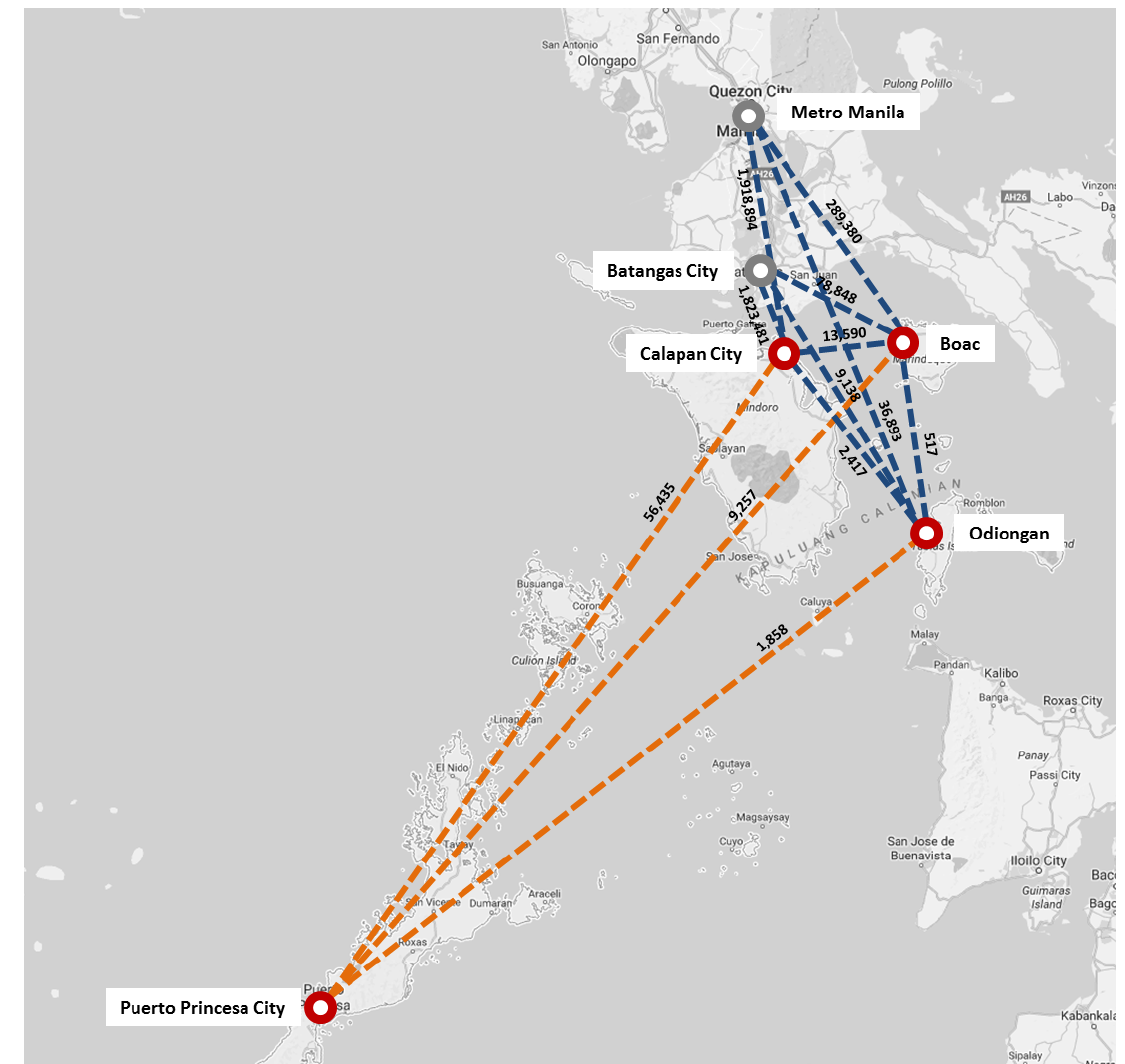
Figure 6. Selected gravity model trip distribution for